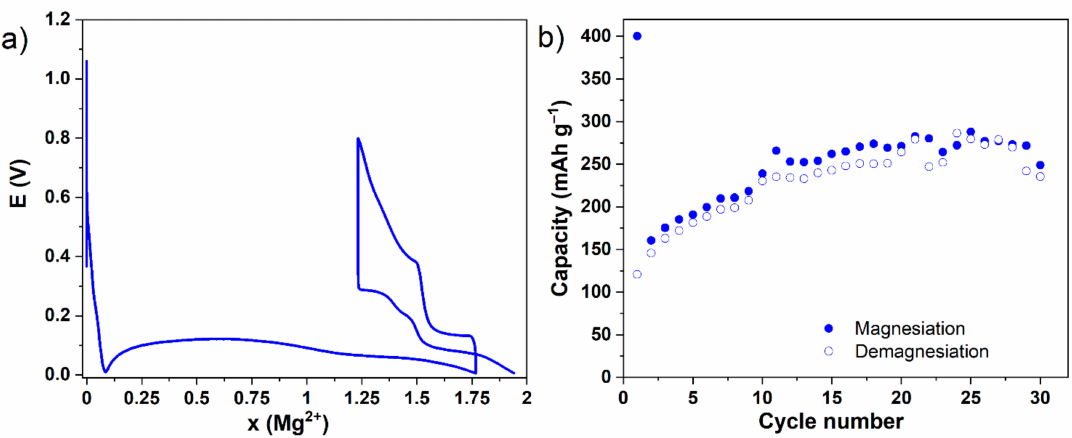
Figure 1. ( a ) Galvanostatic profiles and ( b ) capacities upon cycling for InSb/Mg cells cycled at C/50 rate between 0.8 and 0.005 V in 0.35 M EtMgCl–Et 2